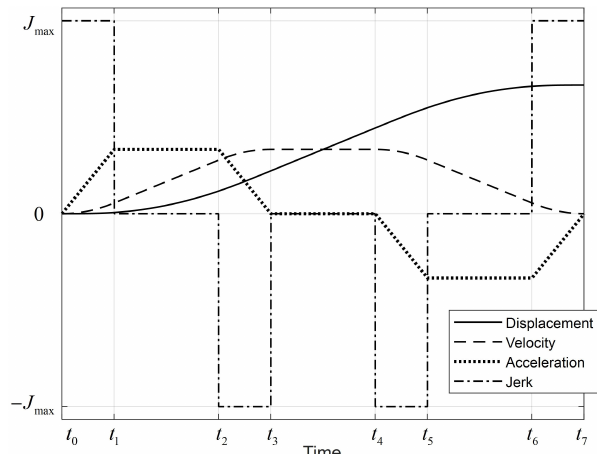
Figure 2. Kinematic trajectory of the third-order